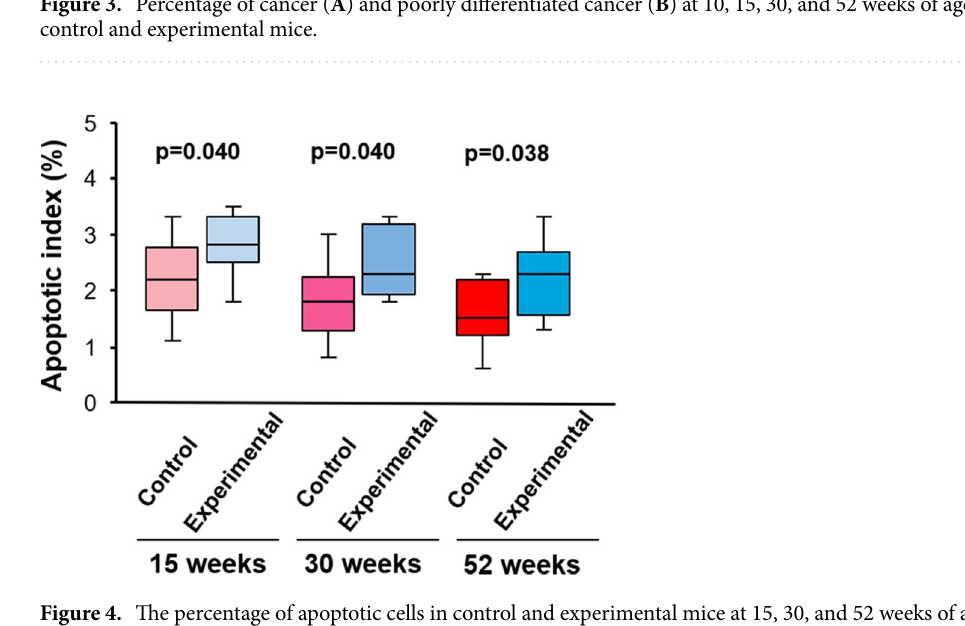
Figure 4. The percentage of apoptotic cells in control and experimental mice at 15, 30, and 52 weeks of